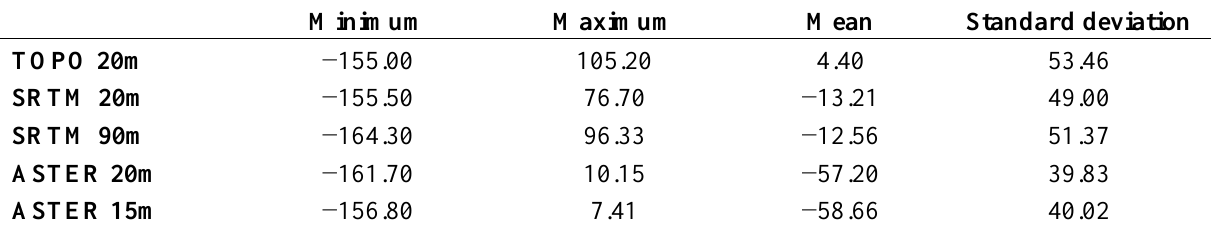
Table 2. Univariate statistics showing DEM errors by subtracting field measured elevations from the DEM elevation